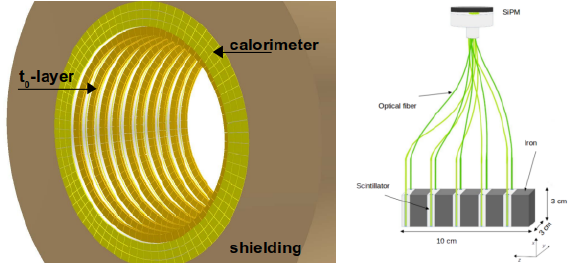
Figure 2. Left: scheme of the ENUBET decay tunnel, instrumented with three layers of calorimetric modules (green), an inner t 0 -layer of scintillator tile doublets (yellow) and an outer shielding of Borated Polyethylene (brown). Right: layout of a single Lateral readout Compact Module (LCM).